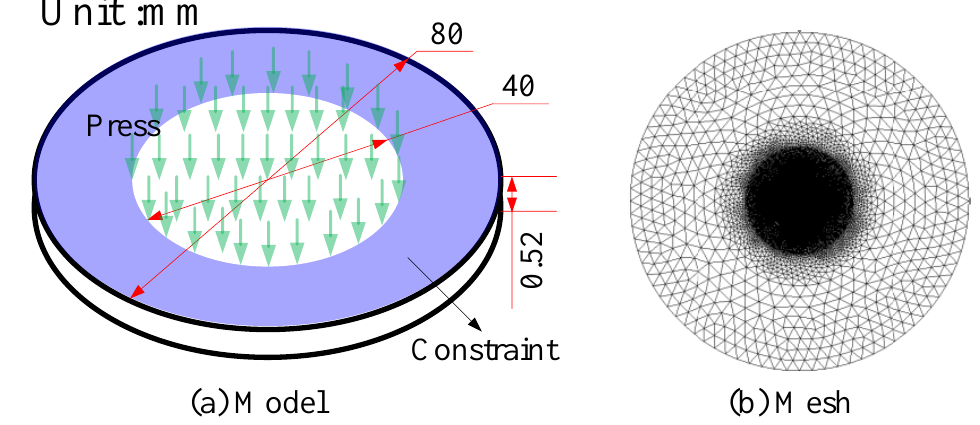
Figure 17. Schematic diagram of test equipment for Case 4.